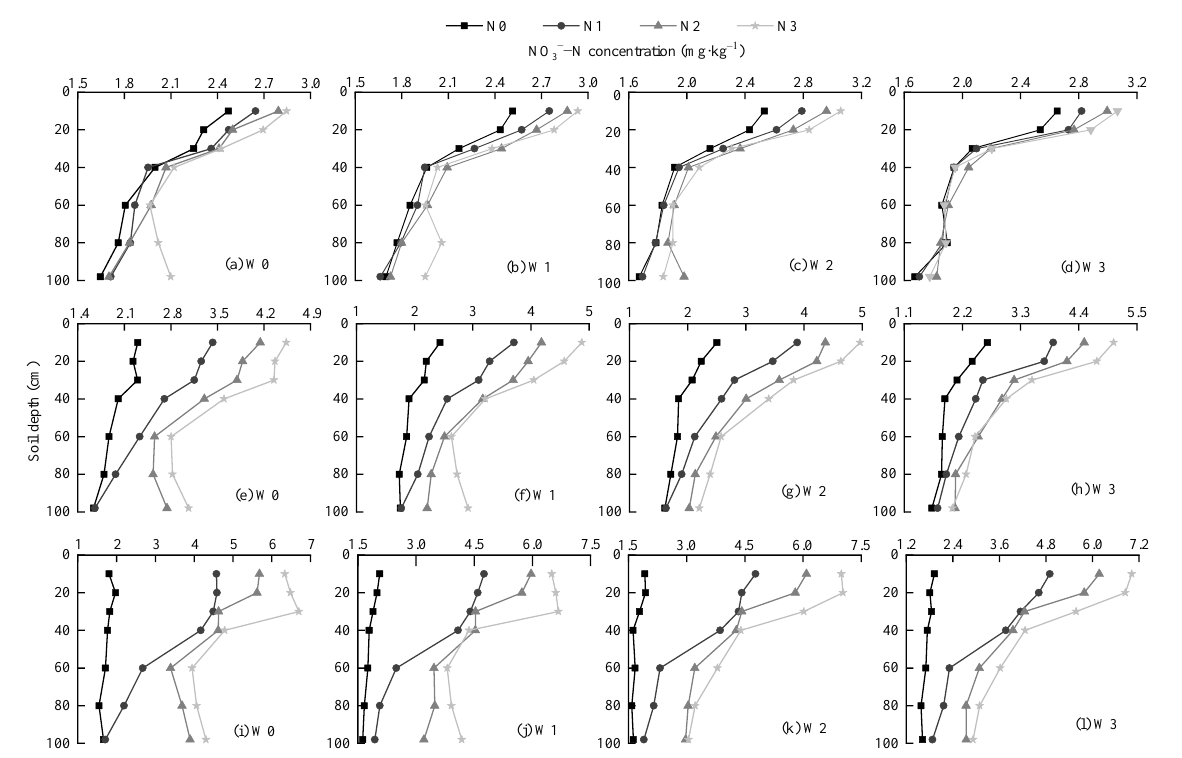
Figure 5. Effects of water-nitrogen regulation on temporal and spatial distribution of NO 3 − –N concentration. ( a – d ), ( e – h ) and ( i – l ) represent soil NO 3 − –N concentration in the first, second and third cut of Bromus inermis under the four irrigation management types, respectively.